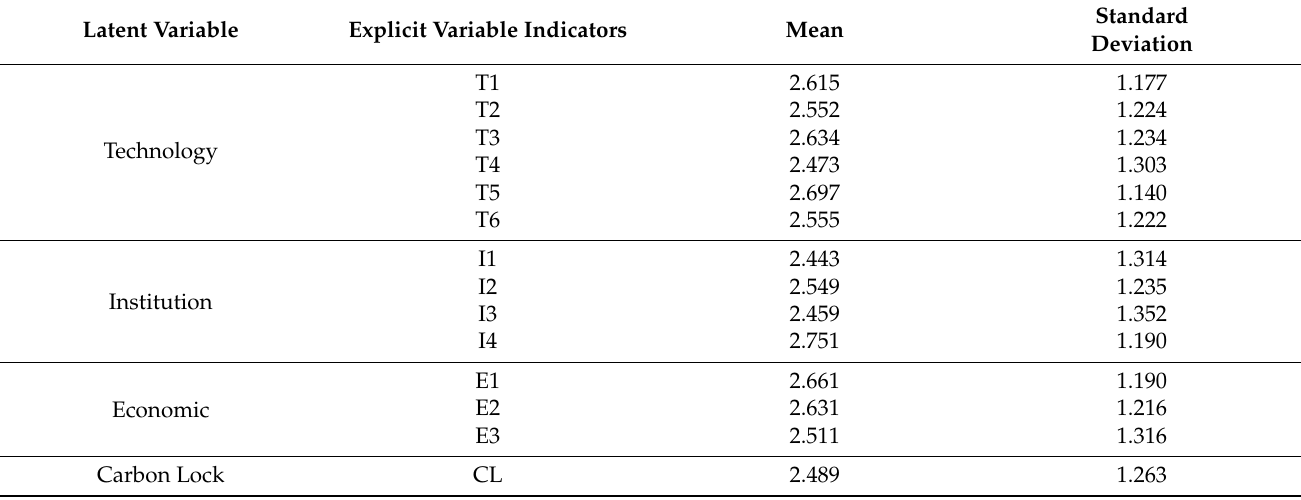
Table 4. Indicator means and standard deviation.